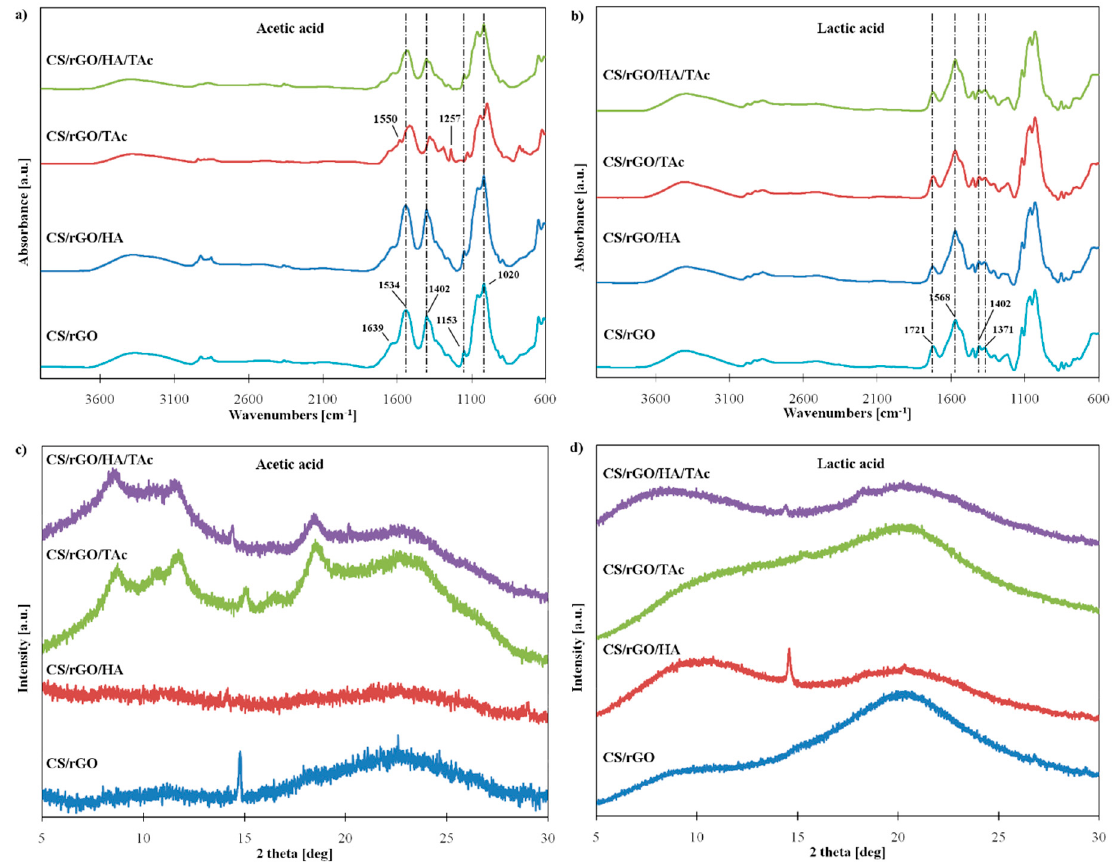
Figure 2. ( a , b ) ATR-FTIR (Attenuated Total Reflection Fourier-Transform Infrared) spectra and ( c,d ) XRD (X-ray Di ff ractometry) patterns of composite samples obtained from ( a , c ) acetic acid-based and ( b , d ) lactic acid-based solvent system (CS—chitosan, rGO—reduced graphene oxide, HA—hydroxyapatite, TAc—tannic acid).